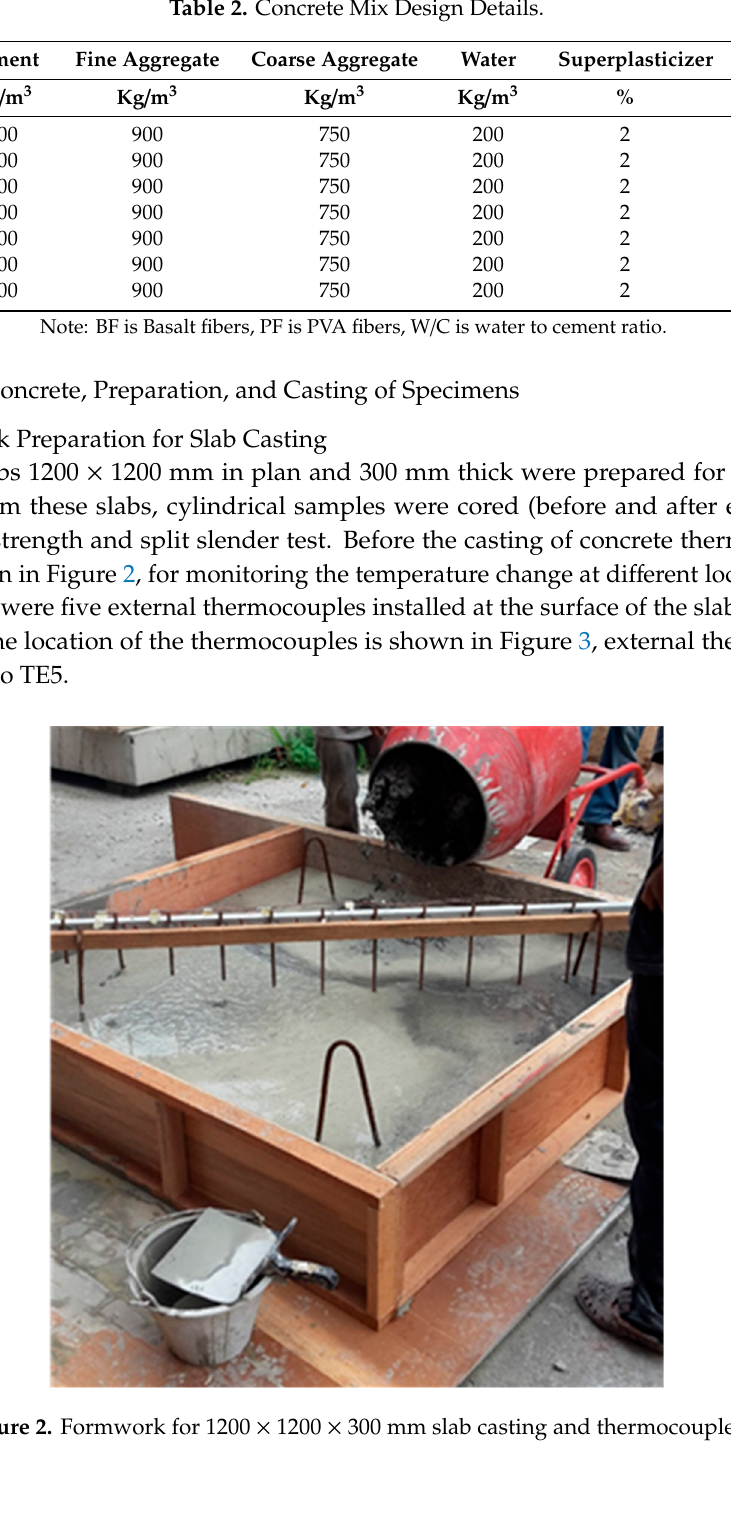
Figure 3. Location of external (TE) and internal (TI) thermocouples. Similarly, there were 11 internal thermocouples installed at an interval of 25 mm with the thickness of the slab (300 mm thick), these are indicated as TI1 to TI11 in Figure 3. TI1 was installed 25 mm below the surface of the slab that was not exposed to the fire. The thermocouple, TI11, was installed 25 mm below the surface of the slab, which was exposed to fire. Therefore, all 11 internal thermocouples were installed in a sequence from TI1 to TI11.